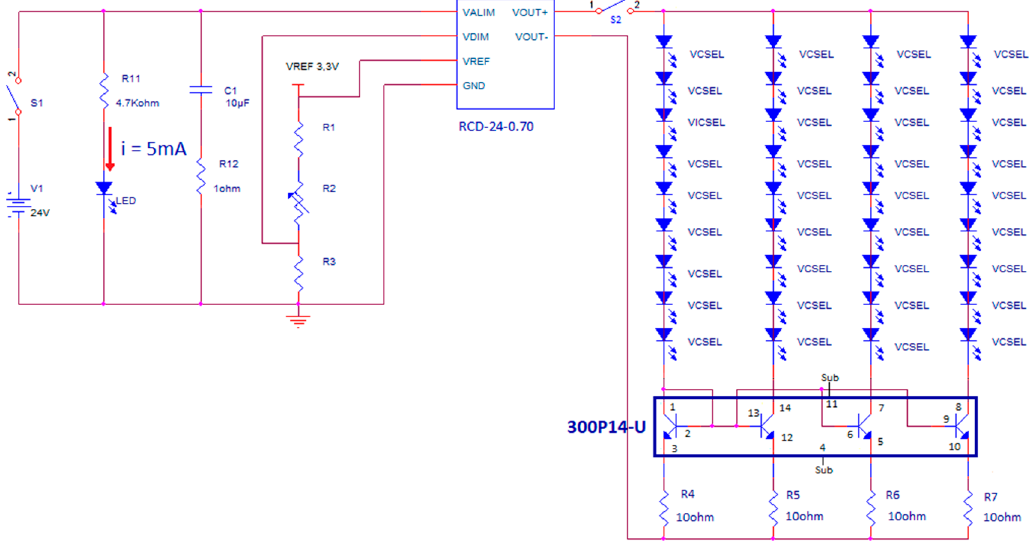
Figure 2. Schematic of the dedicated circuit for current driving the VCSEL matrix.